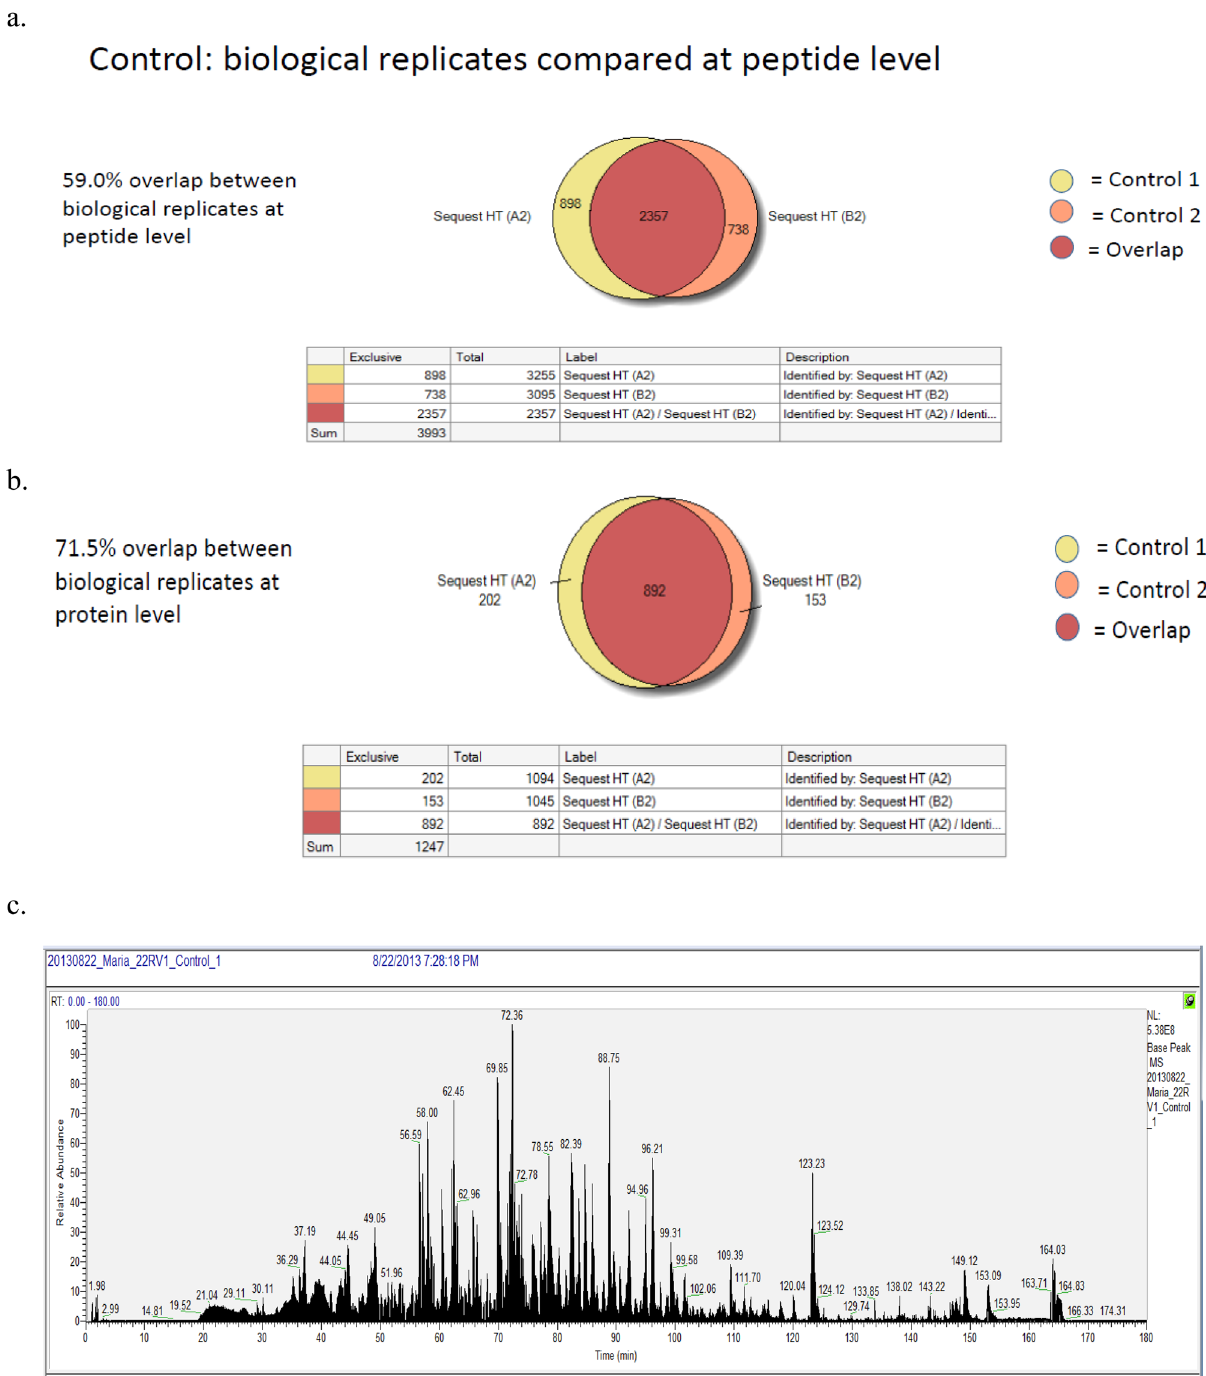
Figure 1. ( a ) Base peak chromatogram of control CWR22Rν1 cells (untreated). ( b ) Base peak chromatogram of MEM treated (40 μg/ml) CWR22Rν1 cells. ( c ) Control biological replicates at the protein level. ( d ) Control biological replicates at the peptide level. ( e ) Overlapping both base peak chromatograms (control + treated) for proteome